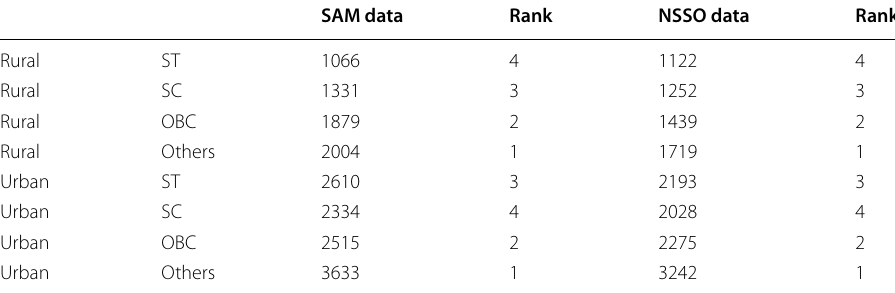
Table 6 Monthly per capita consumption expenditure obtained from SAM and NSSO 68th round survey